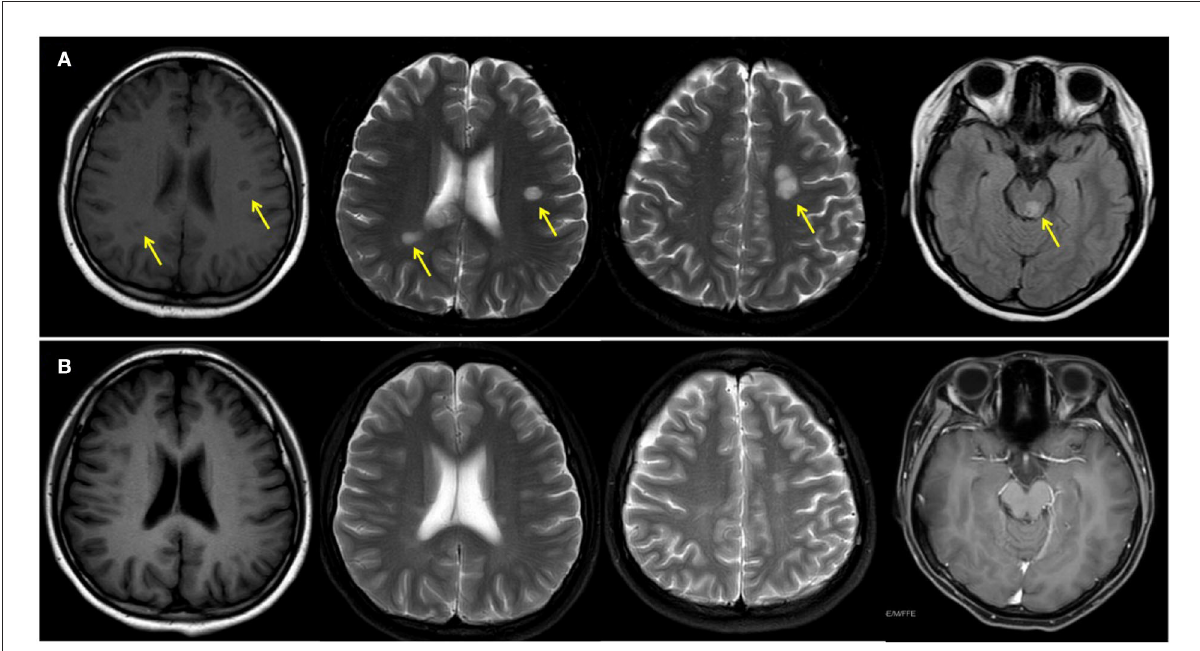
FIGURE1 Magnetic resonance imaging of the brain before (A) and after (B) treatment. Yellow arrows indicate white matter